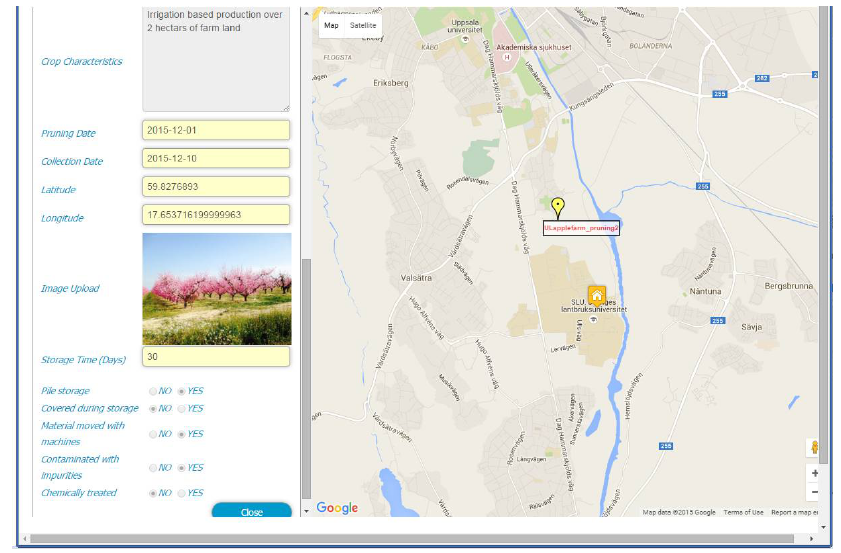
Figure 9. Farmer’s interface as signed in by a raw material producer. The page displays a data entering format where some of the parameters will be added.